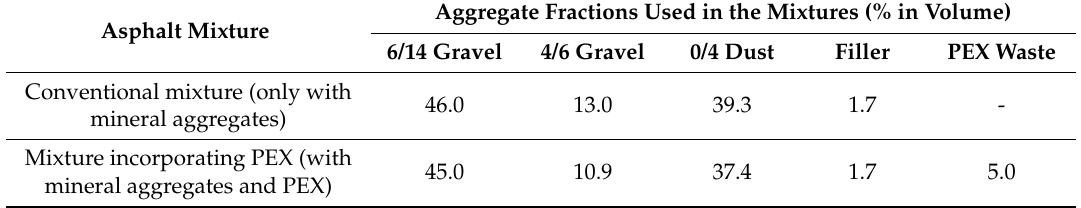
Table 1. Percentage of each fraction of aggregates used in this work for asphalt mixture production.